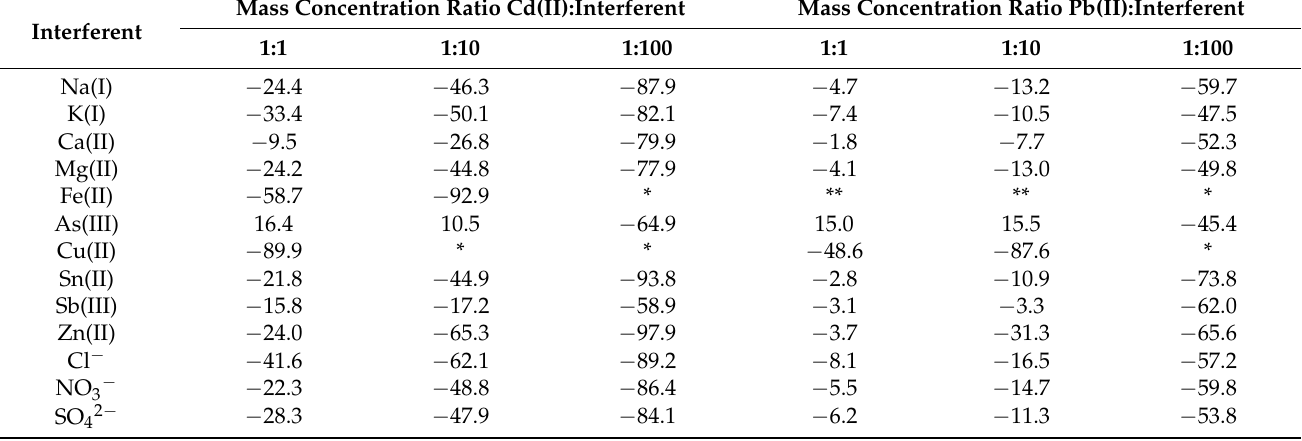
Table 11. The possible interference effect of different species for Cd(II) and Pb(II) determination using Electrode B6 prod .